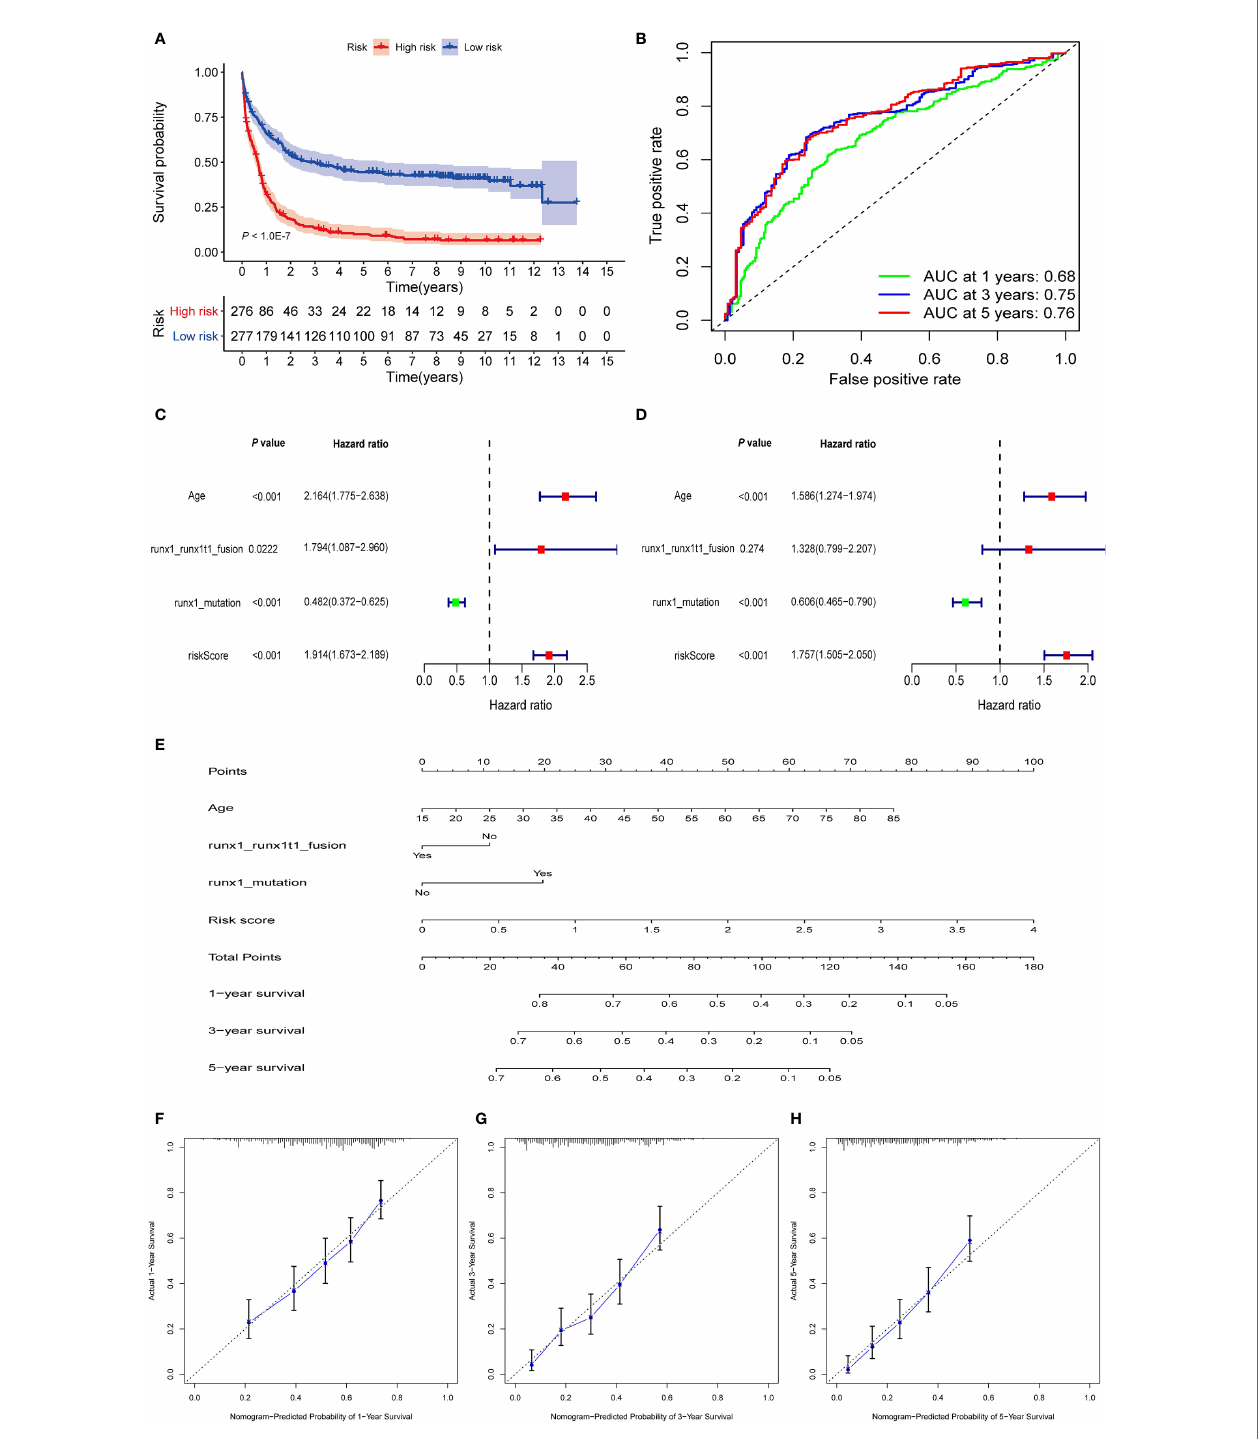
FIGURE 3 | Evaluation of prognostic signature to predict the OS of AML patients. (A) . Patients in the high-risk group had signi fi cantly shorter OS than those in the low-risk group. (B) The AUC curves of the signature for 1, 3, and 5 years. (C) Univariate Cox regression analysis of the risk scores and clinical parameters. (D) Multivariate Cox regression analysis of the risk scores and clinical parameters. (E) Development of autophagy clinicopathologic nomogram for predicting 1-, 3-, and 5-year OS for AML patients by incorporating risk score, age, runx1 and runx1t1 fusion, and mutations in runx1. (F – H) Calibration curves of the autophagy clinicopathologic nomogram-predicted and observed 1-, 3-, and 5-year survival of AML patients. The dashed line represents the ideal performance, and the actual performance of the signature is represented by the blue